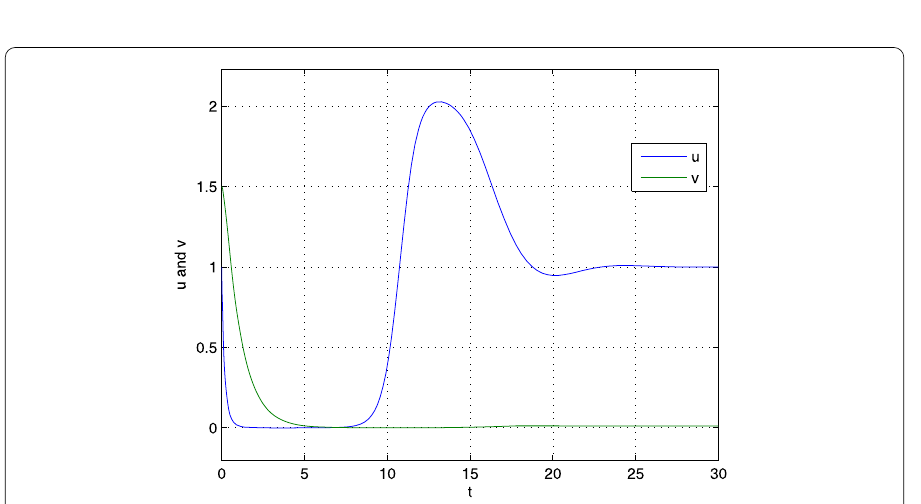
Figure 17 Dynamic behavior of system (1.1) with r 0 = 4, d = 1, a = 1, p = 2, E = 1, m 1 = 1, m 2 = 0.1, c = 0.5, q = 1.1, and k = 30